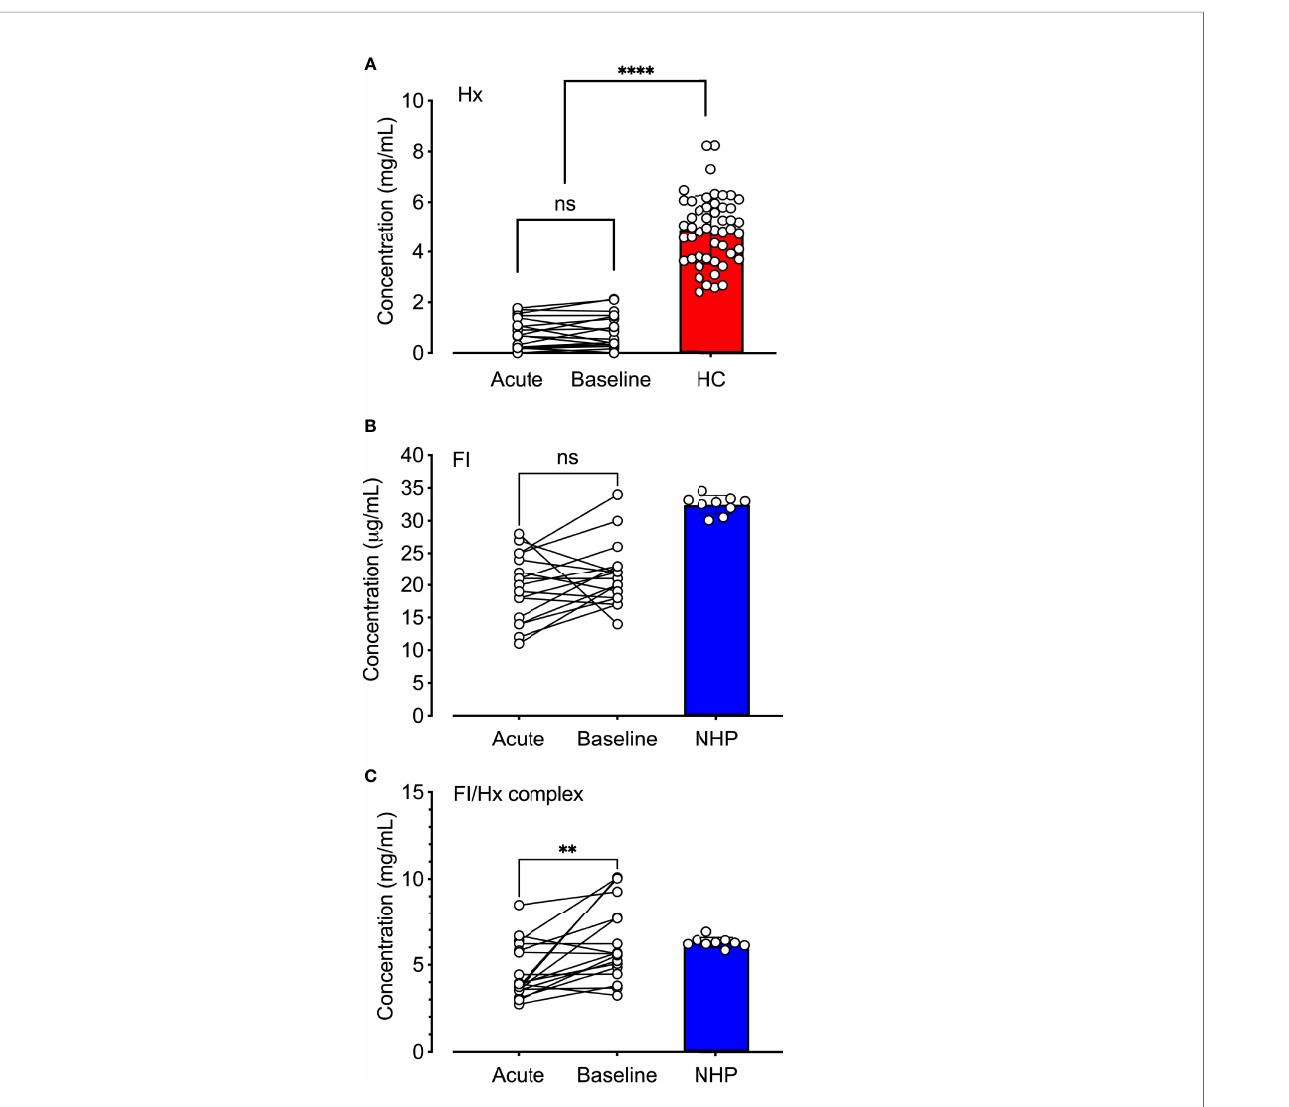
FIGURE 5 | Quanti fi cation of hemopexin, factor I, and factor I-hemopexin-complexes in patients with sickle cell disease. (A) Hemopexin (Hx), (B) factor I (FI), and (C) factor I/hemopexin-complexes (FI-Hx complex) were quanti fi ed in EDTA-plasma samples from patients with SCD (n = 18) obtained during acute vasoocclusive pain crisis (acute), and a follow-up sample was collected at their baseline healthy visit at least four weeks after the acute episode (baseline). Normal human EDTA- plasma from 52 healthy individuals was used as controls for the hemopexin measurements (healthy controls; HC, red), and a pool of NHP (blue) sampled from six healthy donors was used as a control for the FI and the FI-Hx complex measurements. Individual values are shown together with mean and standard deviation. Paired t-test was performed in order to statistically compare the differences between the patients ’ admission to the hospital and the healthy visit. One-way ANOVA was used for the comparison of patients at admission and baseline versus healthy donors. ns, non-signi fi cant, **p < 0.01, ****p <